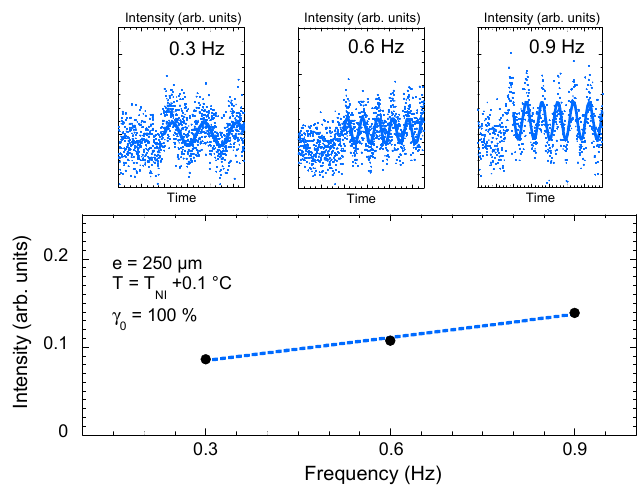
Figure 5. Optical response (transmittance intensity) measured upon applying a low-frequency mechanical strain in the isotropic phase of 4-octyl-4 ′ -cyanobiphenyl (8CB) (T − T NI = +0.1 °C, quartz substrate, strain rate γ 0 = 100%). The transmittance displayed at ω = 0.3 Hz, 0.6 Hz and 0.9 Hz is weak. Device limitations do not enable a conclusive analysis (top figure).